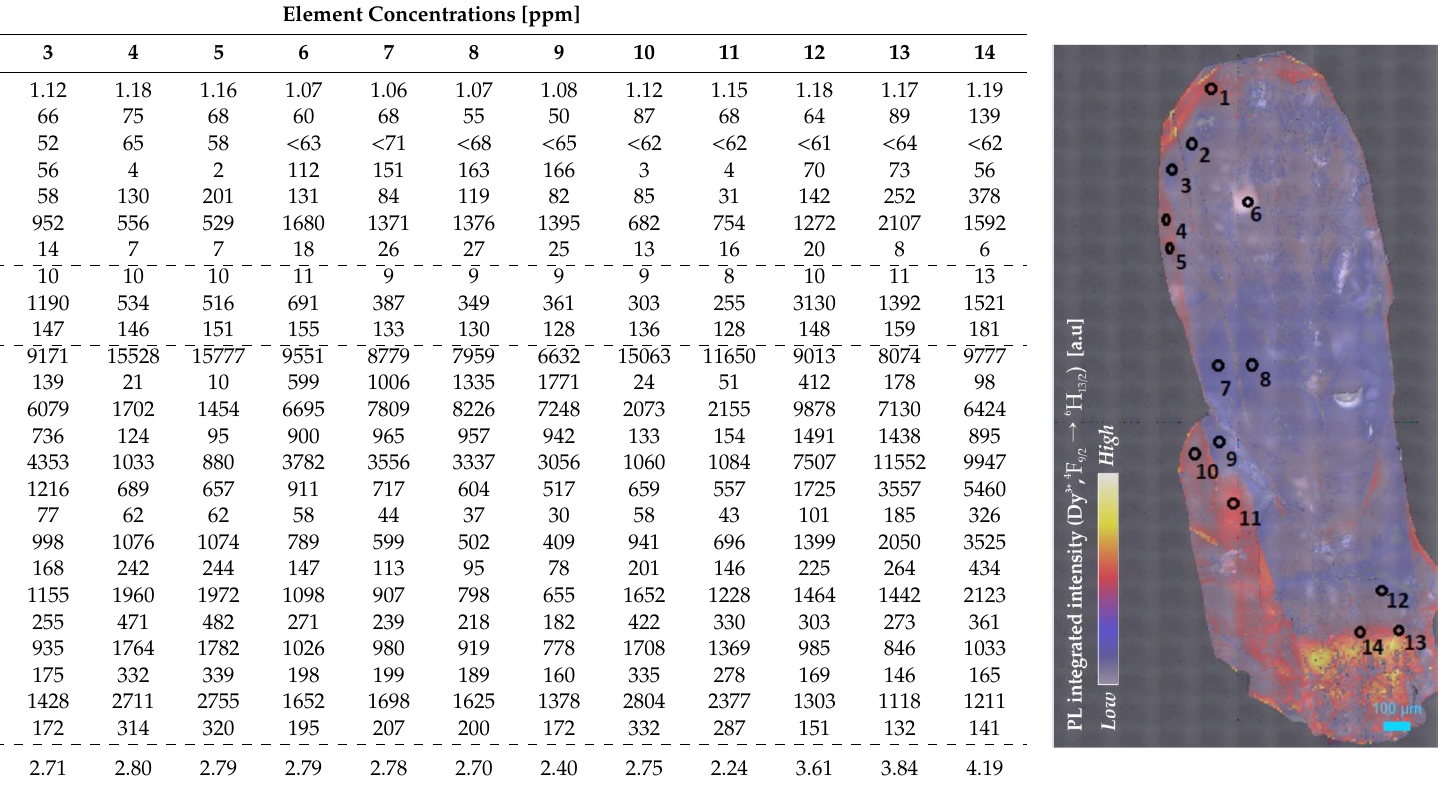
Table A8. Trace-element concentrations from multiple spot measurements on zircon sample MalawiA from Mt. Malosa, Malawi as obtained by LA-ICP-MS (given in ppm, except for Hf and REE totals that are given in wt.-%; totals of REEs comprise Y + La to Lu). Note, that measurement spots for trace-elements di ff er from those chosen for U-Pb isotopic dating (Table A6 and Figure 7a). Spot locations are indicated in a PL hyperspectral map with the integrated intensity of the Dy 3 + signal given color-coded.